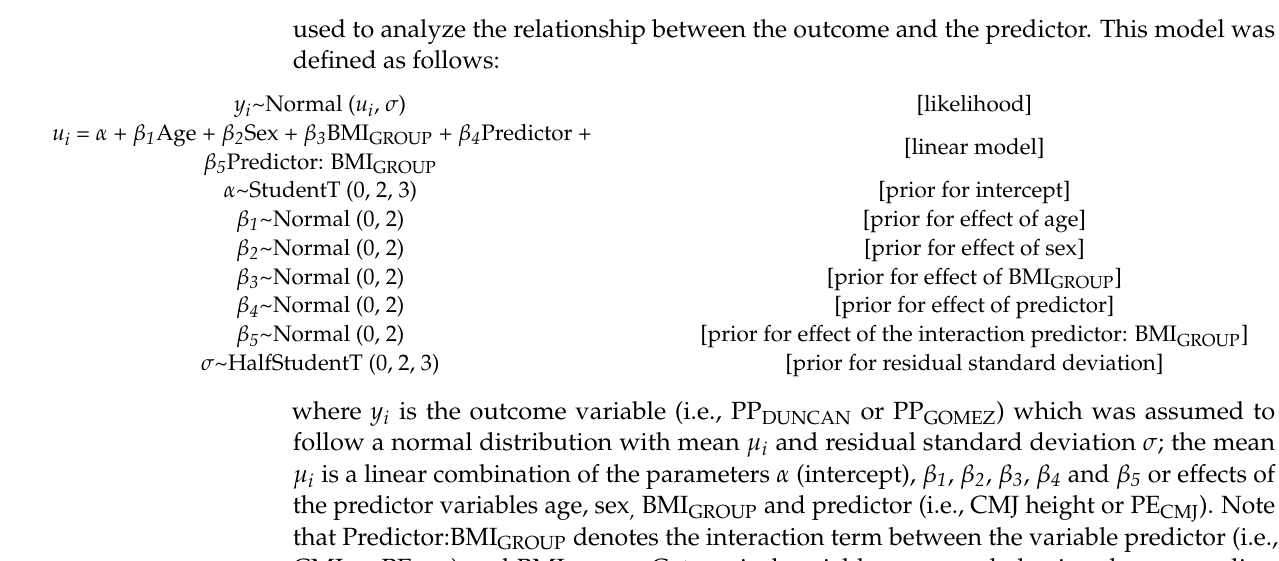
Model 1 : Outcome = PP DUNCAN /predictor = CMJ height Model 2 : Outcome = PP DUNCAN /predictor = PE CMJ Model 3 : Outcome = PP GOMEZ /predictor = CMJ height Model 4 : Outcome = PP GOMEZ /predictor = PE